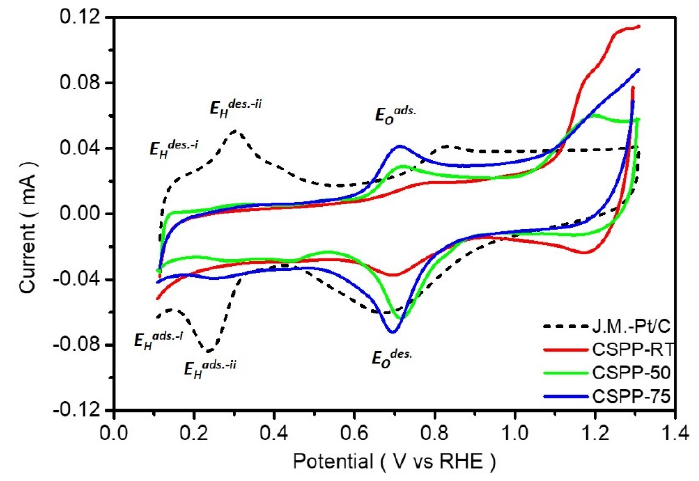
Figure 4. The CV curves of CSPP NCs compared with commercial J.M.-Pt/C catalyst. The represented CV curves are collected in an O 2 -saturated 0.1 M KOH electrolyte solution. Based on the above-discussed HRTEM, XRD, XAS, and CV results, the nanostruc- tures of CSPP NCs have been proposed and shown in Scheme 1. Accordingly, multi- layered hierarchical structures with different configurations are formed in all the CSPP NCs. First, when the impregnation temperature is controlled to 25 °C, the Pt-clusters’ emerging SnO 2 layer is formed over SnPd 2 domains with CoO 2 underneath (i.e., CSPP- RT). Further raising the impregnation temperature to 50 °C (i.e., CSPP-50 NC) resulted in a severe change in the configuration of surface as well as sub-surface regions. The cross- referencing results of HRTEM, XRD, and XAS consistently confirm that due to enhanced kinetics of galvanic replacement reaction, Co atoms are exposed to surface as well as sub- surface regions, and the inert SnO 2 layer vanished. Moreover, combining the results of CV analysis with microscopy and spectroscopic observation, the formation of CoPt nanoal- loys and Pt-clusters on the surface of CSPP-50 NC is confirmed. Moreover, the results of physical structure inspections suggest the formation of SnO 2 -capped multi-metallic CoS- nPdPt alloy over CoO 2 support in CSPP-70 NC.